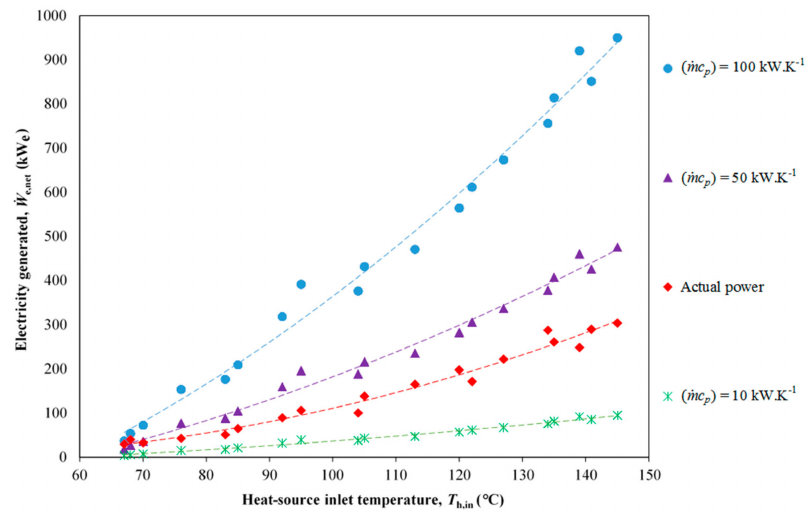
Figure 8. Electrical power generated by ORC engines that utilize the thermal energy available in the streams listed in Table 5 as a function of the heat-source inlet temperature, with the heat sink at 25 ◦ C (“actual power” points and curve). Also shown is the power generated when utilizing streams with the same temperature di ff erences as in Table 5 but with heat capacity rates (